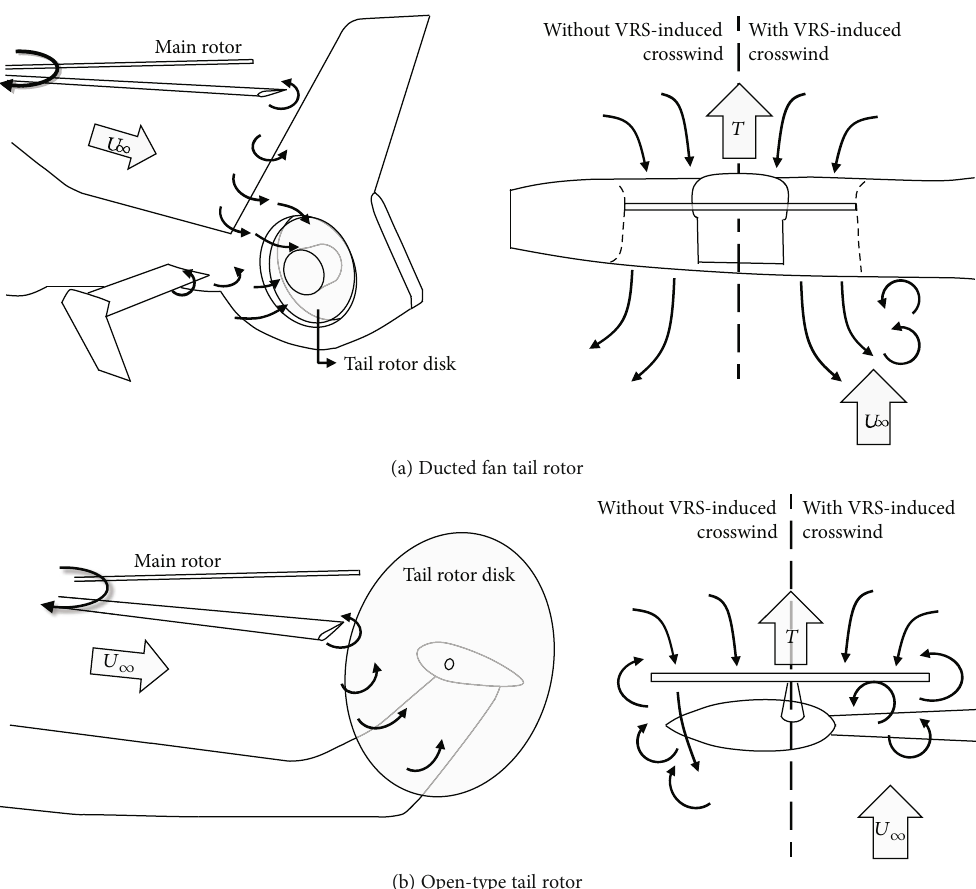
Figure 20: Schematics of fl ow around the tail